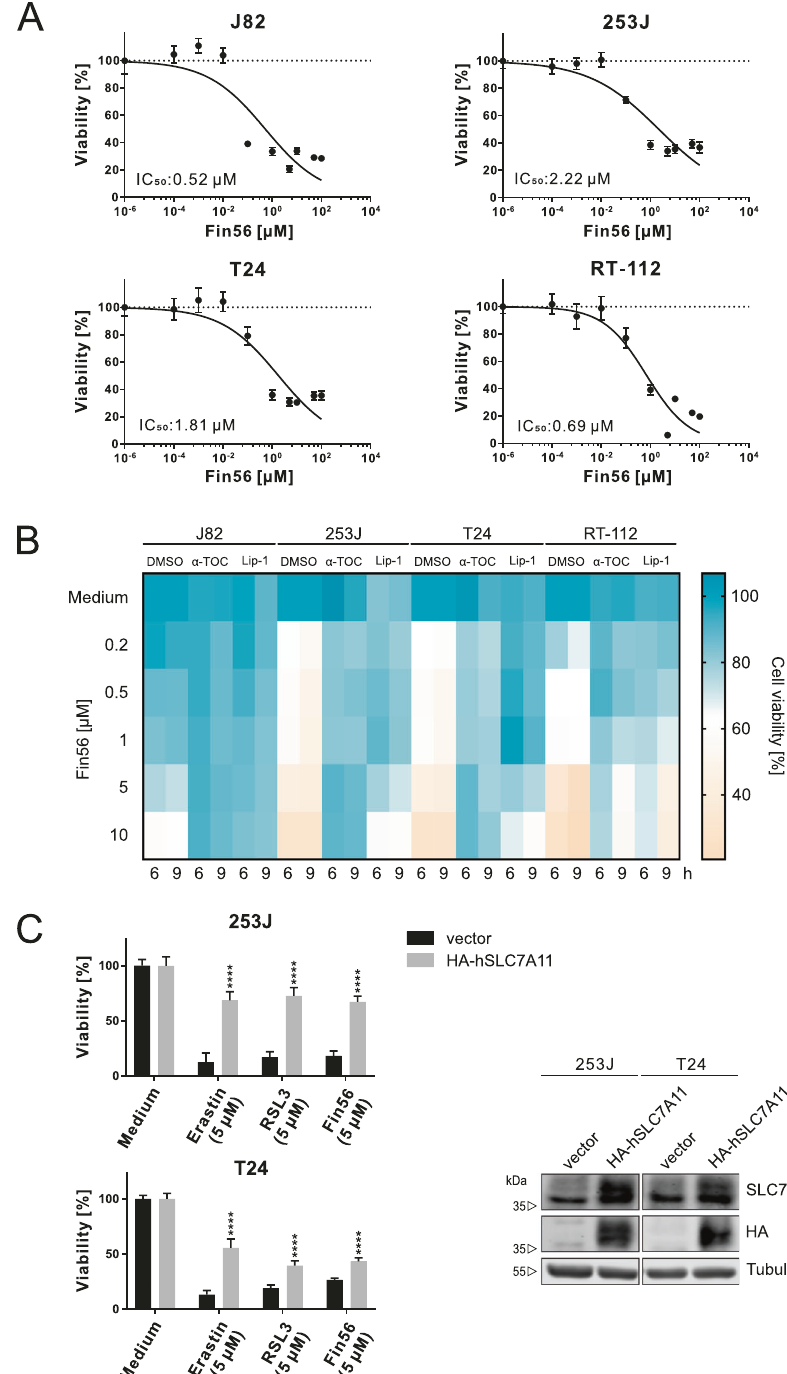
Fig. 2 Fin56 induces ferroptosis in bladder cancer cells. A J82, 253J, T24, and RT-112 bladder cancer cells were treated with different concentrations (0.1 nM – 100 µM) of Fin56 for 72 h. After treatment, cell viability was measured using MTT assay. Results are shown as means ± SD of two independent experiments performed in quadruplicate for each treatment. B Cell viability heatmap of the effects of different ferroptosis inhibitors on cell death induced by Fin56. J82, 253J, T24, and RT-112 were treated with indicated concentrations of Fin56 with or without α -tocopherol ( α -TOC, 100 µM) or liproxstatin-1 (Lip-1, 500 nM) for 6 or 9 h. After treatment, cell viability was measured using MTT assay. Results are from two independent experiments performed in triplicates for each treatment. The corresponding histograms and statistical analyses are shown in supplementary fi gure S1. C HA-hSLC7A11-overexpressing 253J or T24 cells and their corresponding vector control cells were treated with 5 µM erastin, RSL3, or Fin56 for 24 h. After treatment, cell viability was measured using MTT assay. Results are shown as means + SD of two independent experiments performed in triplicates for each treatment. P values were determined by two-way ANOVA with Sidak ’ s post hoc test. **** p < 0.0001 (comparison between vector- and HA-hSLC7A11 -transfected cells). In order to con fi rm the overexpression of HA-hSLC7A11, cells were lysed and cellular lysates were immunoblotted for SLC7A11, HA, and